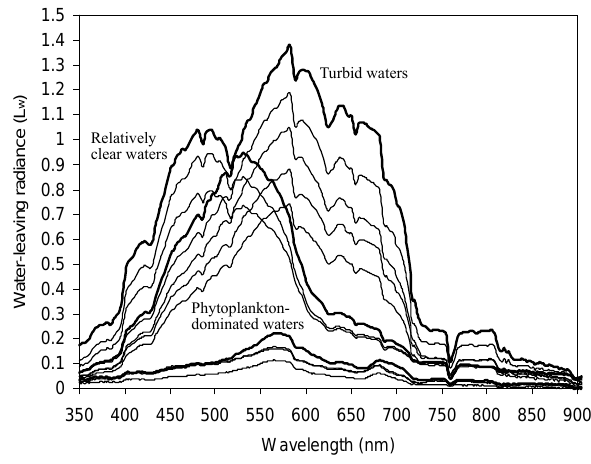
Fig. 6. The water-leaving radiance spectra collected in phytoplankton-dominated, turbid and relatively clear waters of the KSS, KSWS and southern YS.